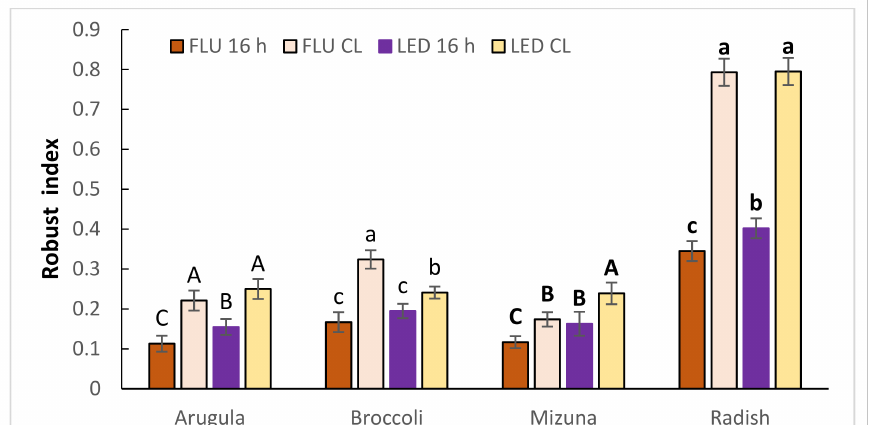
Figure 1. The robust index of arugula, broccoli, mizuna and radish microgreens grown under 16 h photoperiod or CL provided by fluorescent (FLU) or LED lamps. The results are presented as the mean ± standard error. Different letters for each plant species indicate significant differences between the mean values at p < 0.05. Table 2. Leaf chlorophyll ( a + b) content, share of chlorophyll in light-harvesting complex II (LHCII), carotenoid, anthocyanin, and flavonoid contents of microgreens grown under 16 h photoperiod or continuous light provided by fluorescent (FLU) lamps or LEDs.